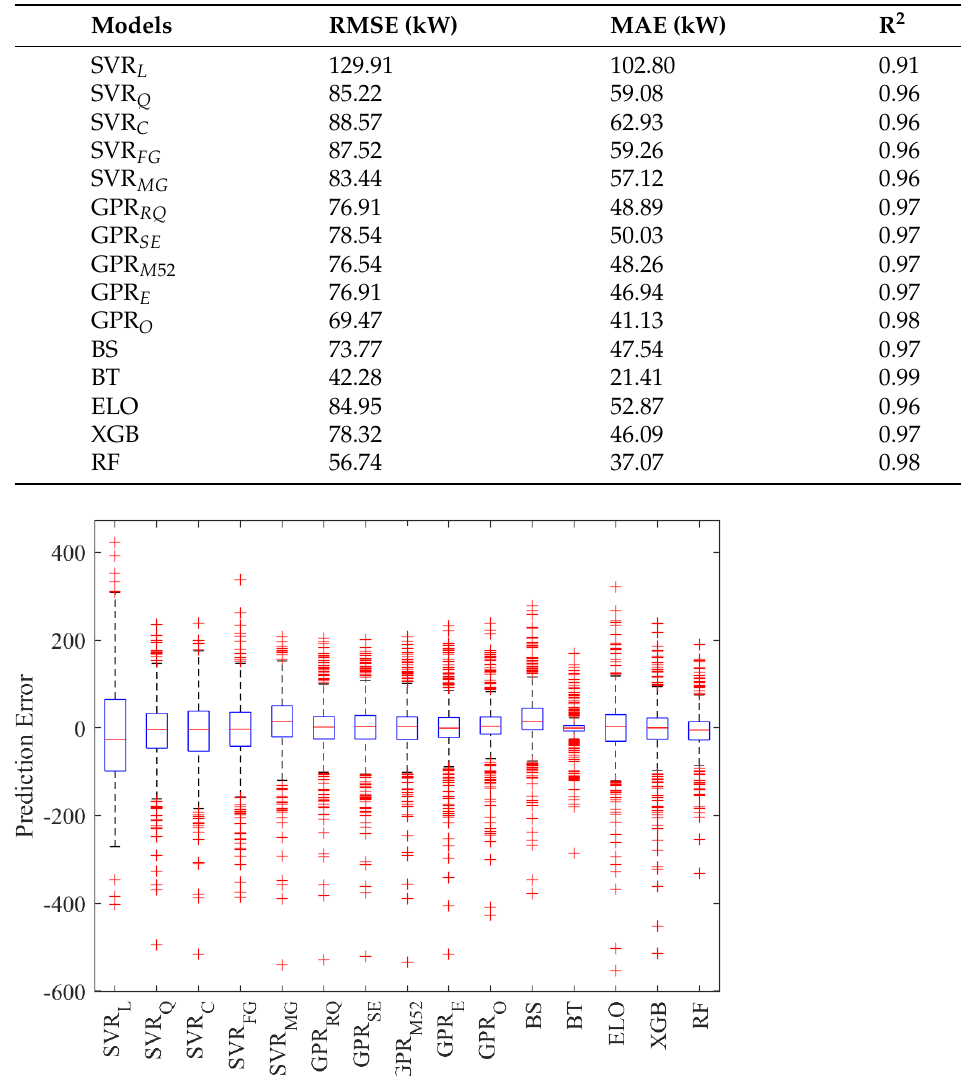
Table 5. Prediction results of the fifteen models using France data.